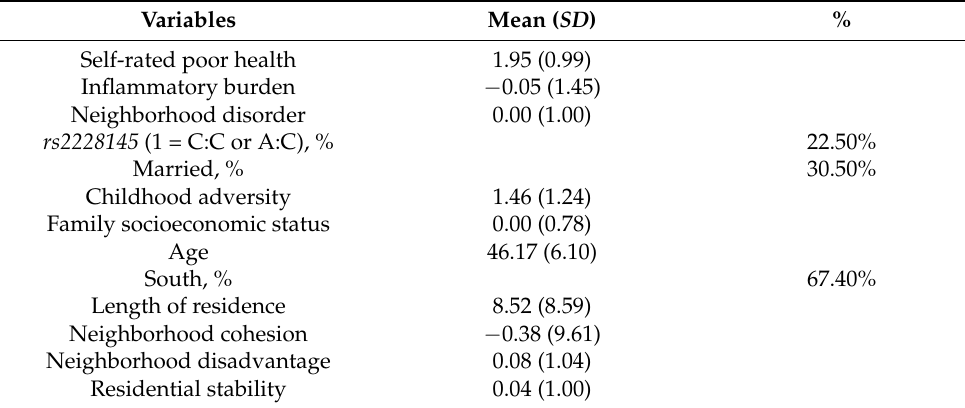
Table 1. Descriptive statistics for study variables ( N = 325).